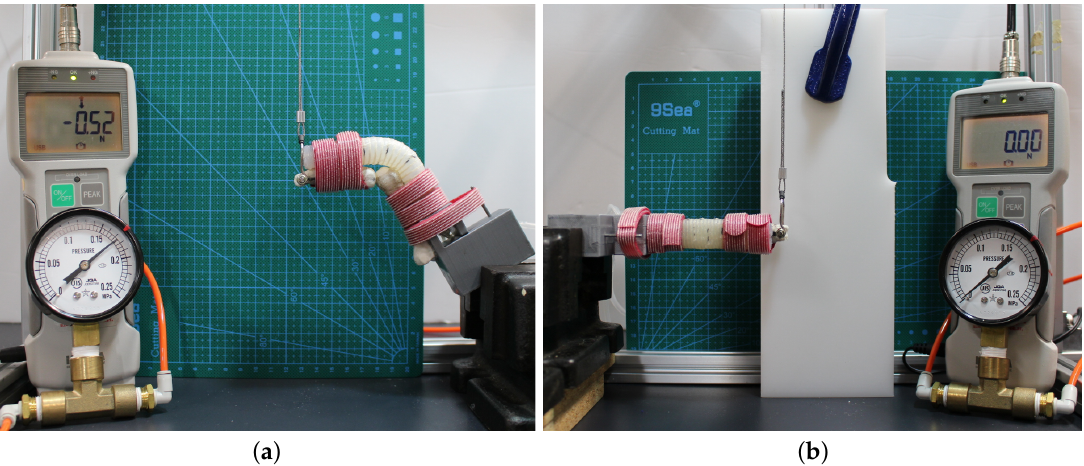
Figure 5. Torque measurement setup with the dummy MCP joint. The joint angle was set to 0 ◦ , 30 ◦ and 60 ◦ for flexion and 0 ◦ and 20 ◦ for abduction-adduction, keeping the distal bone perpendicular to the force gauge (above). Joint torque was then calculated from the measured force. ( a ) Parallel-D flexion, 60 ◦ , 175 kPa; ( b ) Parallel-D abduction-adduction to the right, 0 ◦ , 0 kPa.